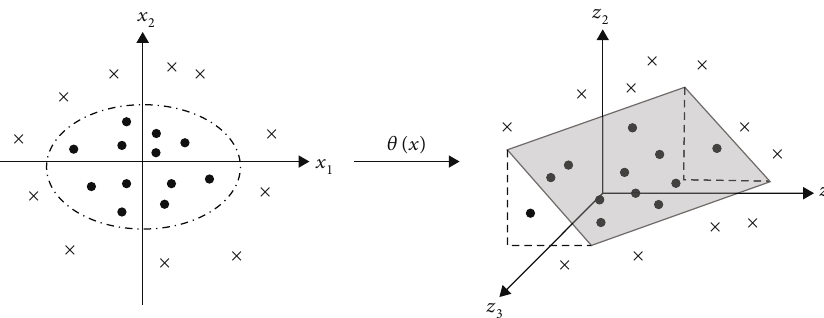
Figure 8: The kernel function is used to map the low dimensional feature vector to the high dimensional feature space.